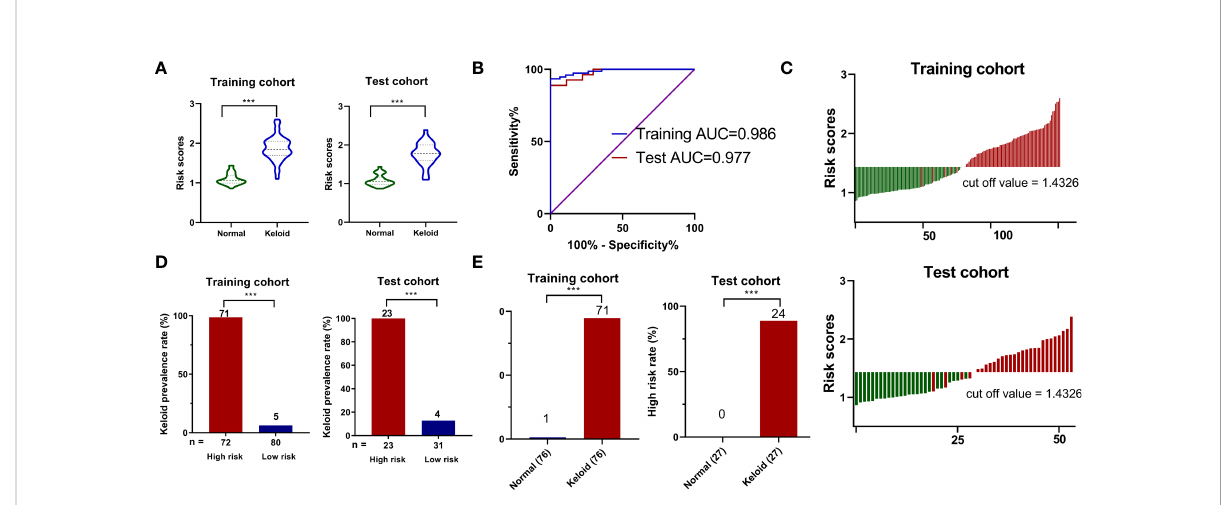
FIGURE 5 The construction of risk score model for identifying keloid. (A) Respective values of keloid risk scores between the keloid and control groups in the training and test cohorts. (B) ROC analysis of sepsis risk scores in predicting keloid. (C) An optimal threshold point value was de fi ned as 1.4326, and all participants were classi fi ed into low-risk (<cutoff) and high-risk (>cutoff) score groups. (D) Analysis of keloid prevalence rate between the high-risk and low-risk groups in the training and test cohorts. (E) Analysis of high-risk rate between the keloid and control groups in the training and test cohorts. ***p <